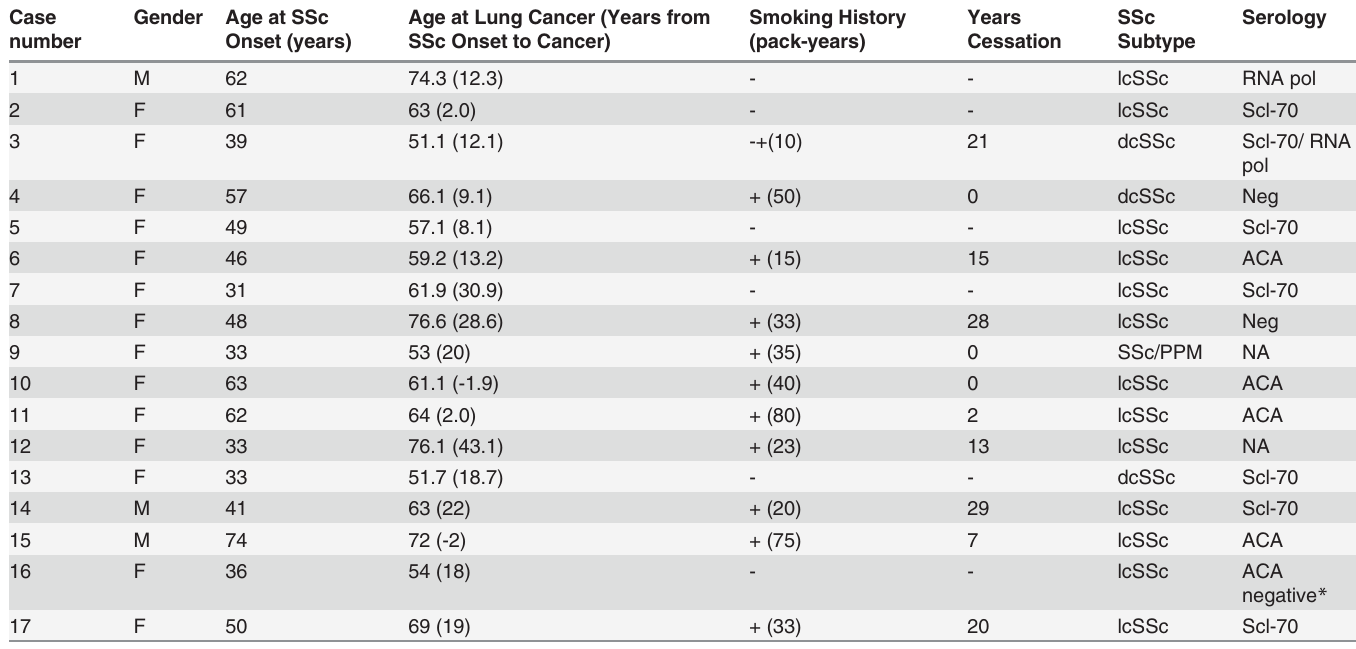
Table 1. Demographics, smoking history and SSc subtype and